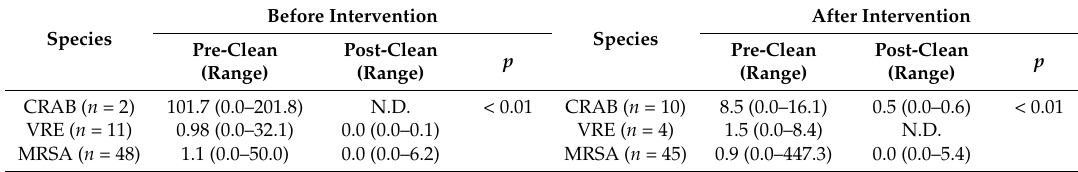
Table 3. Median culture values (CFU/cm 2 ) of CRAB, VRE and MRSA before and after daily cleaning during the two study